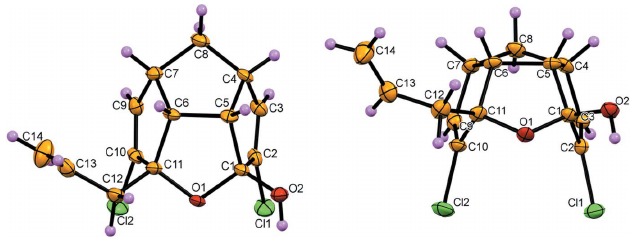
Figure 1 The molecular structure of 1 ( a ) viewed from above and ( b ) viewed from the front. Displacement ellipsoids are drawn at the 50% probability level.